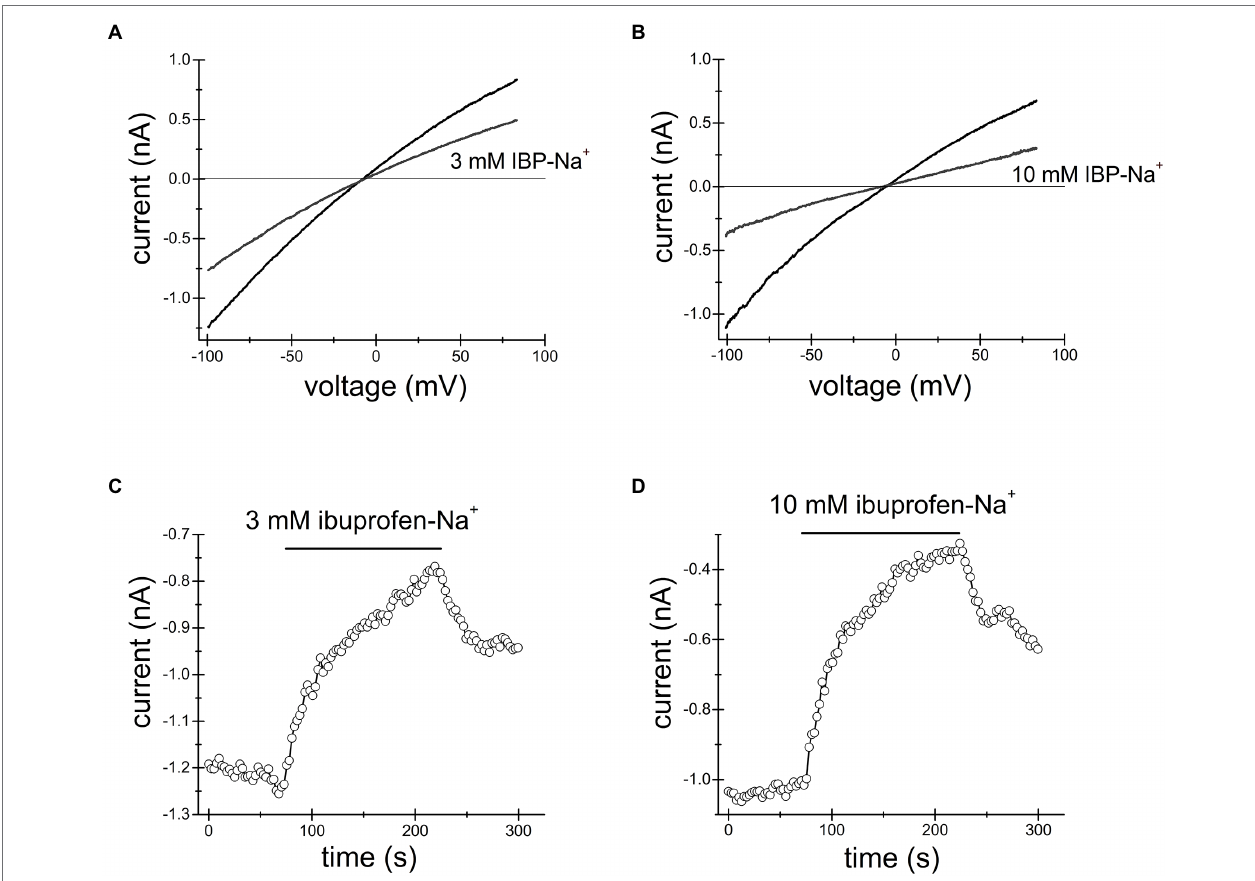
FIGURE 3 | Ibuprofen-Na + inhibits TRPM7 current. TRPM7 monovalent I–V relations obtained in the absence and presence of 3 mM (A) and 10 mM (B) ibuprofen. (C,D) show the time course of ibuprofen effect in the same cells. Current amplitudes were measured at − 100 mV and plotted against time. Representative recordings from n = 7 (A,C) and n = 3 (B,D) Jurkat T